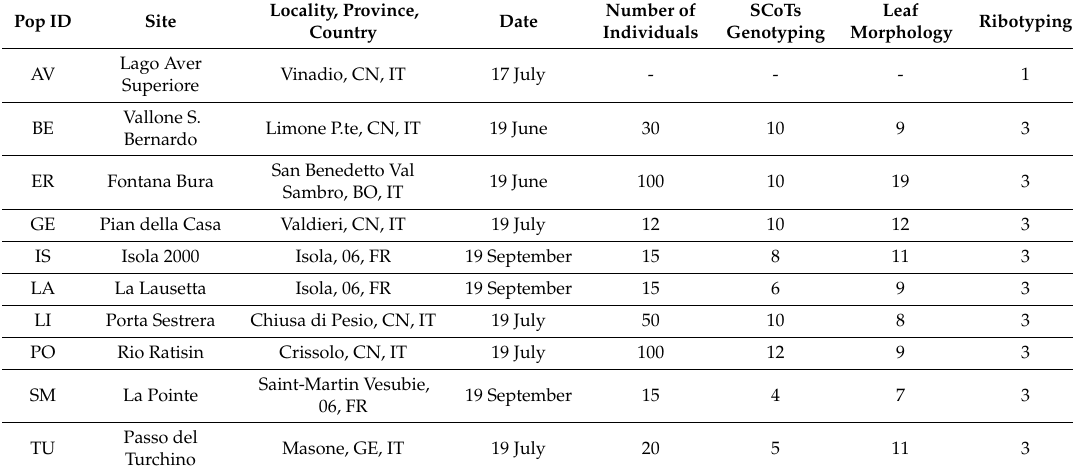
Table 4. Populations description: samples are from ten di ff erent populations. For each population are reported (from left to right column): the populations ID; site names; location details; sampling dates; approximate number of individuals; number of samples (individuals) genotyped with start codon targeted polymorphism (SCoT); number of leaves (individuals) measured for the leaf morphology analysis; number of samples (individuals) genotyped with single-nucleotide polymorphisms research in the nuclear ribosomal internal transcribed spacer marker